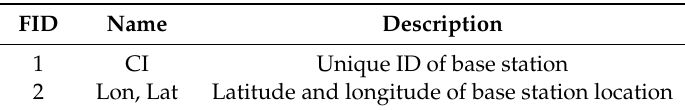
Table 2. Base station index data